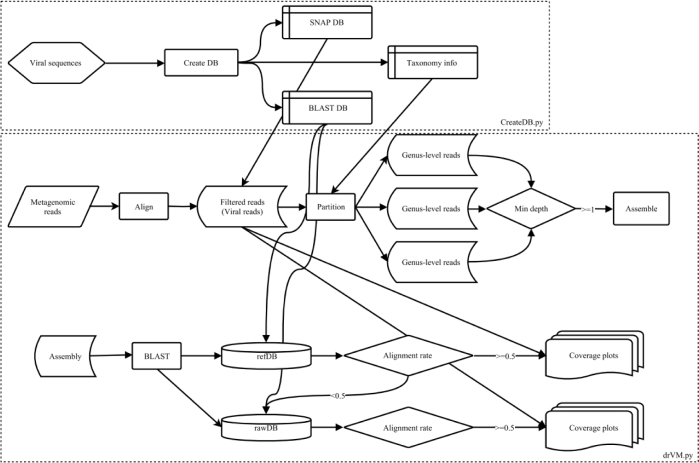
A schematic flowchart of drVM. CreateDB.py processes viral sequences to produce SNAP and BLAST databases. drVM.py analyzes NGS reads to produce viral genomes.